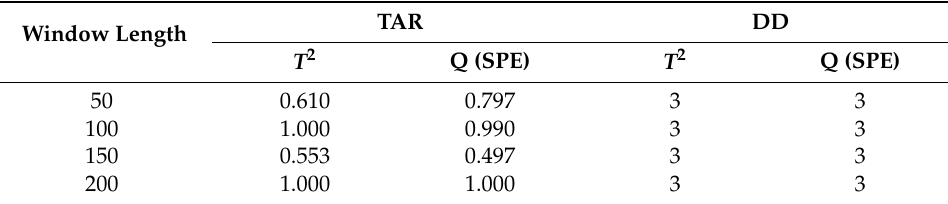
Table 10. Monitoring AG mill operational state using Method II. Window